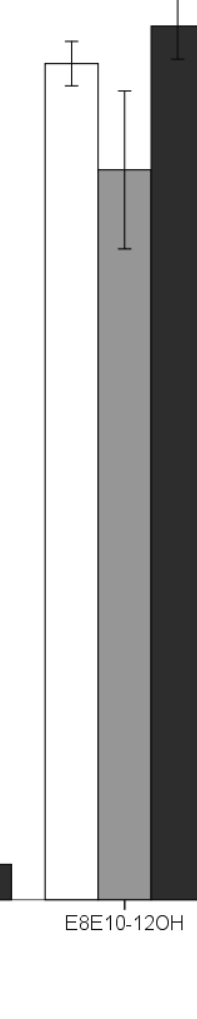
Figure 2. Mean relative percentage (±SEM) of the integrated sex pheromone components in females from the three populations with sample size >10. The sum total of all compounds within a population equals 100%. ** p < 0.01. (cid:2)MD: females collected from a population that had not been exposed to mating disruption; +MD: females collected from a population that had been exposed to mating disruption. See text for further